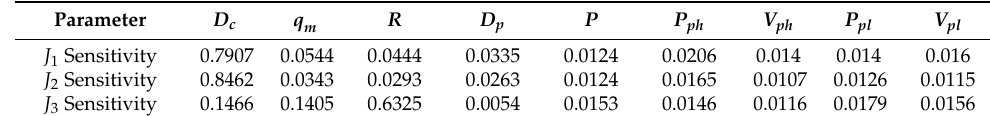
Table 4. Sensitivity of the parameters.